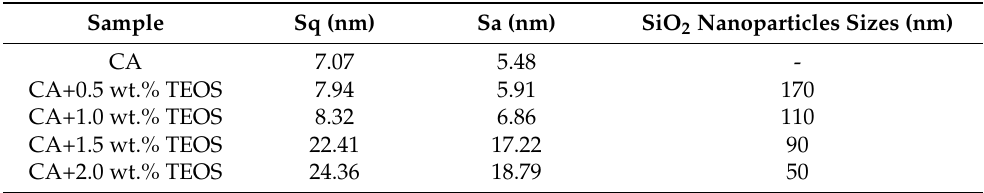
Figure 3. Histograms and surfaces profiles (small plots) taken along a line from 2D AFM images of: ( a ) CA, ( b ) CA+0.5 wt.% TEOS, ( c ) CA+1.0 wt.% TEOS, ( d ) CA+1.5 wt.% TEOS and ( e ) CA+2.0 wt.% TEOS films. Table 1. Surface roughness parameters, including the root-mean-square roughness (Sq) and average roughness (Sa) and SiO 2 nanoparticles